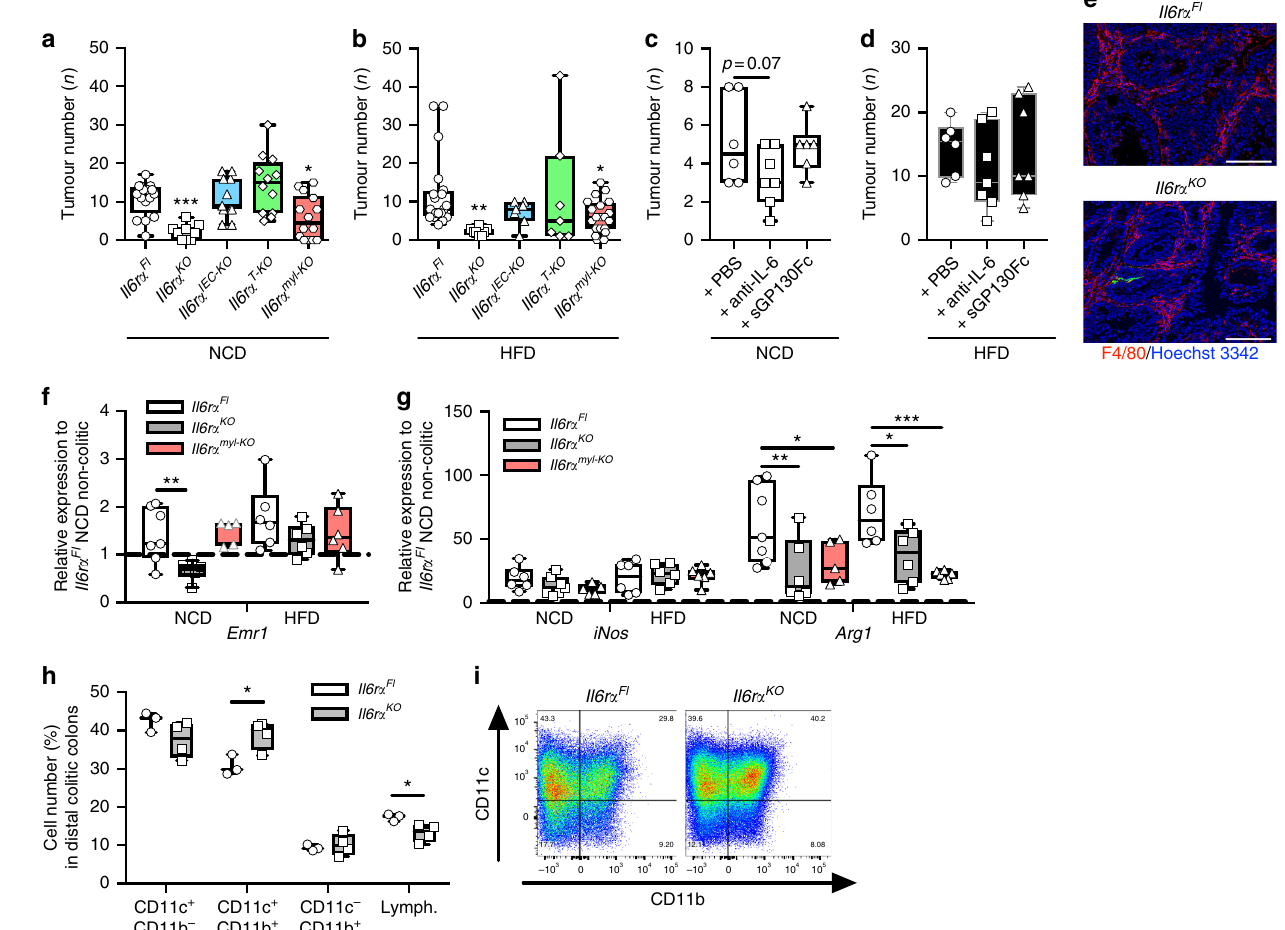
Fig. 2 IL-6R α de fi ciency in myeloid cells reduces CAC. AOM/DSS-induced tumour numbers in colons of a NCD-fed ( n = 9 – 16) and b HFD-fed ( n = 7 – 20) 17-week-old Il6r α Fl , Il6r α KO , Il6r α IEC-KO , Il6r α T-KO , Il6r α myl-KO mice at day 62 of the 1.5% AOM/DSS protocol. Tumour numbers counted at day 62 of 17-week-old c NCD ( n = 6 – 7) or d HFD ( n = 6 – 7)-fed C57BL/6 mice injected with either PBS, 500 µ g anti-IL-6 antibody or 150 μ g sGP130Fc at day 3 of the 1.5% AOM/DSS protocol. e Representative immuno fl uorescent staining of macrophages using F4/80 antibody (red) counterstained by Hoechst 3342 (blue) in colons of 17-week-old HFD-fed Il6r α Fl and Il6r α KO mice at day 62 of the 1.5% AOM/DSS protocol. f , g qPCR analysis of indicated gene expression in tumours ( n = 6 – 7) of 17-week-old NCD or HFD-fed Il6r α Fl , Il6r α KO and Il6r α myl-KO mice at day 62 of the 1.5% AOM/DSS protocol, results are presented relative to non-colitic distal colon of Il6r α Fl NCD at day 0. h Relative cell number (%) of CD11c + / CD11b − dendritic cells, CD11c + /CD11b + and CD11c − /CD11b + macrophages and CD11c − /CD11b − lymphocytes from lymphocyte gate SSC/FSC in colitic colons of NCD-fed Il6r α Fl and Il6r α KO mice at day 13 of the 1.5% AOM/DSS protocol. i Representative FACS plots of CD11c and CD11b expression in immune cells from h . AOM, azoxymethane; DSS, dextran sodium sulphate; NCD, normal chow diet; HFD, high-fat diet; CAC, colitis-associated colorectal cancer. Centre line: median; box limits: 1st and 3rd quartiles; whisker: maximum to minimum, * p ≤ 0.05, ** p ≤ 0.01 and *** p ≤ 0.001 two-tailed unpaired Student ’ s t -test h , one-way a – d or two-way ANOVA followed by Fisher LSD f , g . Scale bar, 100 μ